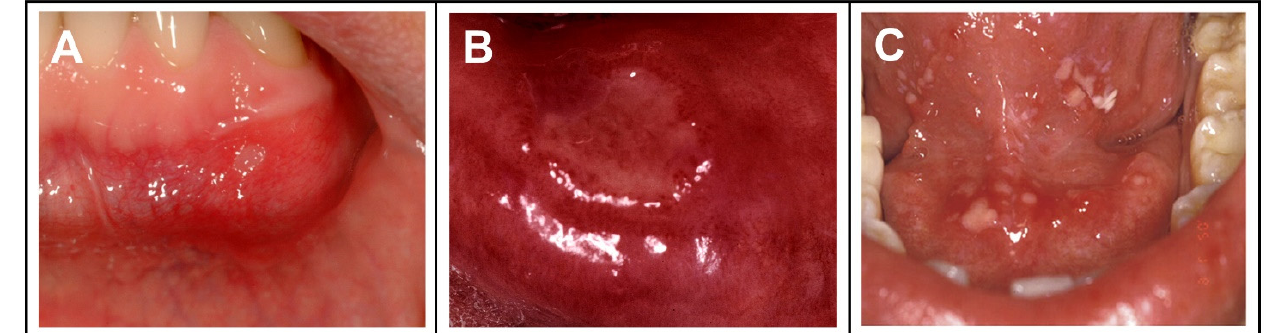
Figure 4. Schematic diagram of a patient with oral ulcers. ( A ) Mild oral ulcer, reprint